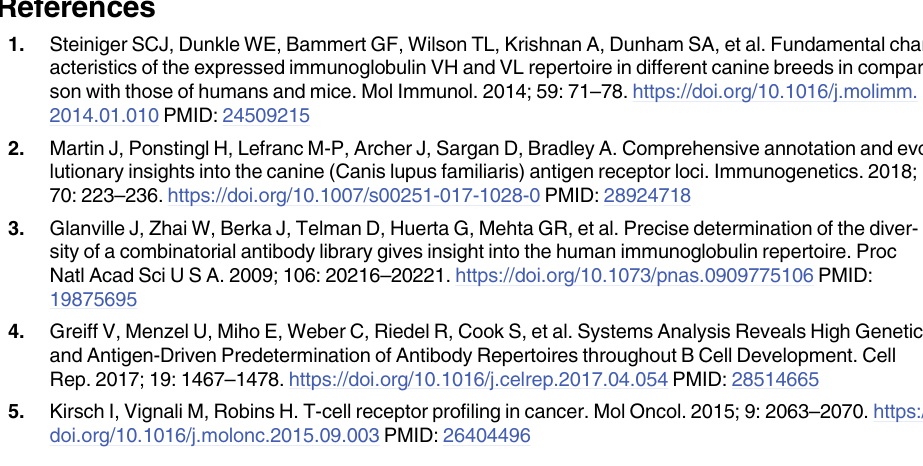
S6 Table. Mean diversity estimates and standard errors. S7 Table. Proportional usage of IGHV3-38 and IGHV4-1 in cases at T1 and